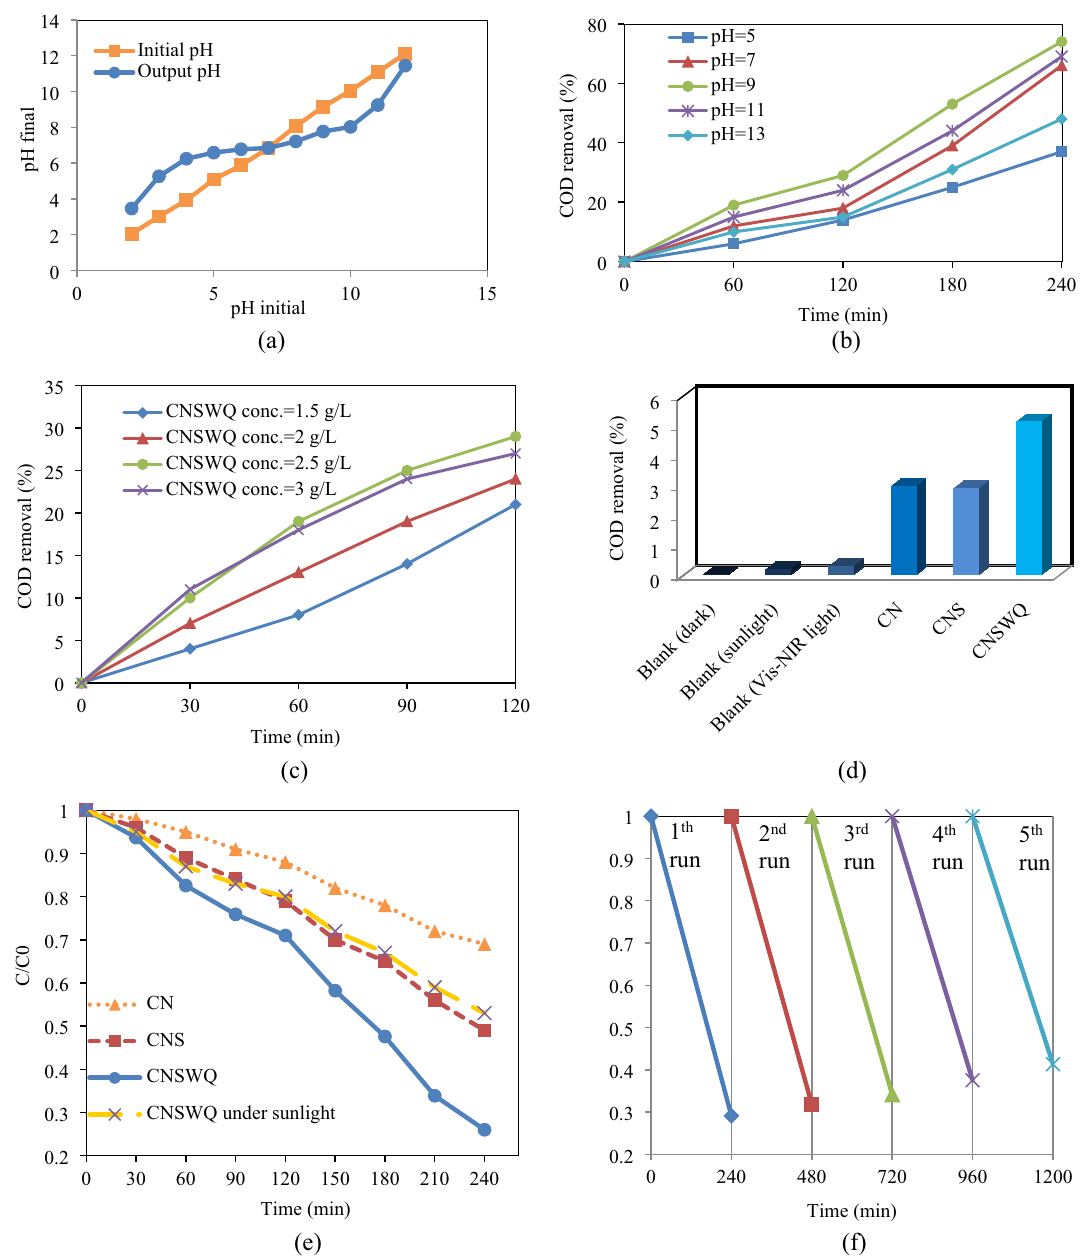
Figure 4. ( a ) pH PZC of CNSWQ and effect of ( b ) pH, ( c ) photocatalyst dosage, ( d ) adsorption (dark), Vis–NIR light (alone), sunlight (alone), ( e ) photocatalysts under Vis–NIR lamp and sunlight irradiation, and ( f ) cycling runs on COD degradation of landfill